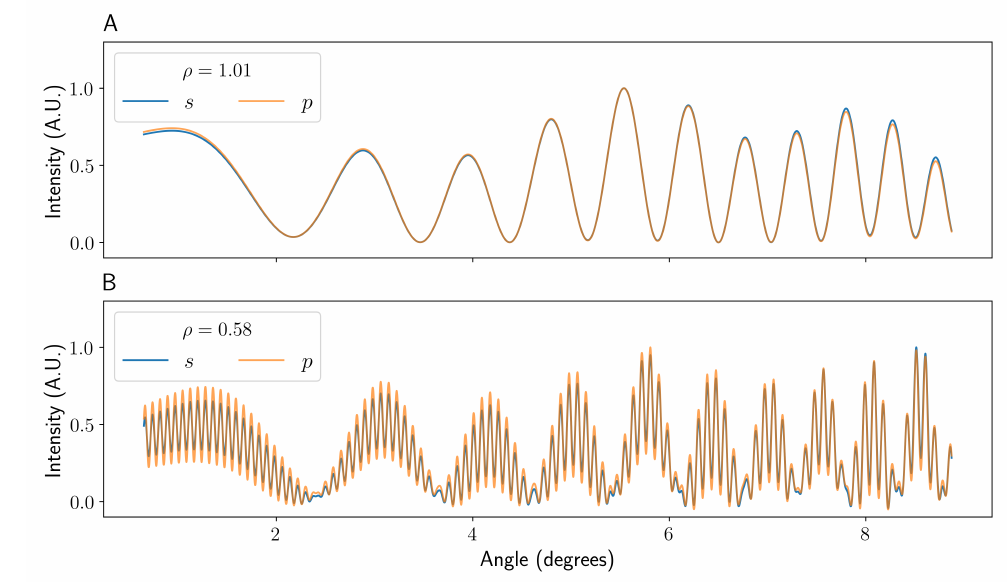
Figure 4. A graph showing the simulated intensity patterns seen for a capillary higher ( A ) and lower ( B ) than the ρ = 1 limit for both s - and p -polarised incident light. The data were taken 9cm horizontally and 0.75cm vertically from the capillary, with a simulated camera width of 1.3cm. The angle is given in degrees from β = π . The data have been normalised between 0 and 1 to aid comparison.